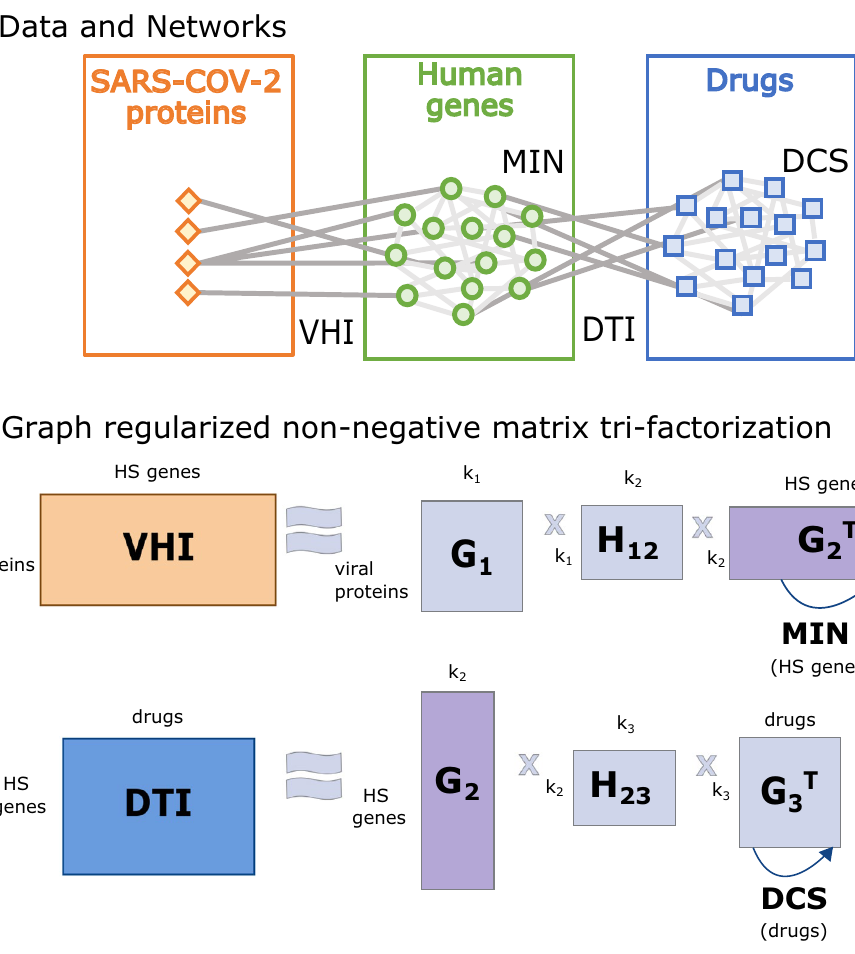
Figure 1. Illustration of the data and framework. (a) Schematic illustration of datasets used in this study. Three data types are represented: SARS-CoV-2 proteins (in orange), human genes (in green) and drugs (in blue). Two relational datasets connect different types of data: virus-host protein–protein interactions (VHIs) and drug-target interactions (DTIs). Network structural knowledge from these data types is contained in the molecular interaction network (MIN) and the drug chemical similarity (DCS) network. (b) Graph-regularized non-negative matrix tri-factorization (GNMTF) used for fusing the VHIs, DTIs, MIN and DCS networks. The matrix factor G 2 is shared across decompositions to simultaneously decompose the VHI and DTI networks. Network structure (topology) information from the MIN and DCS networks are incorporated into the data fusion by using two regularization terms (illustrated by arcs with arrows). The parameters k 1 , k 2 and k 3 indicate the numbers of clusters of viral proteins, human genes and drugs,